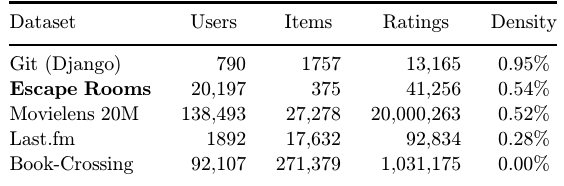
Table 1. Datasets